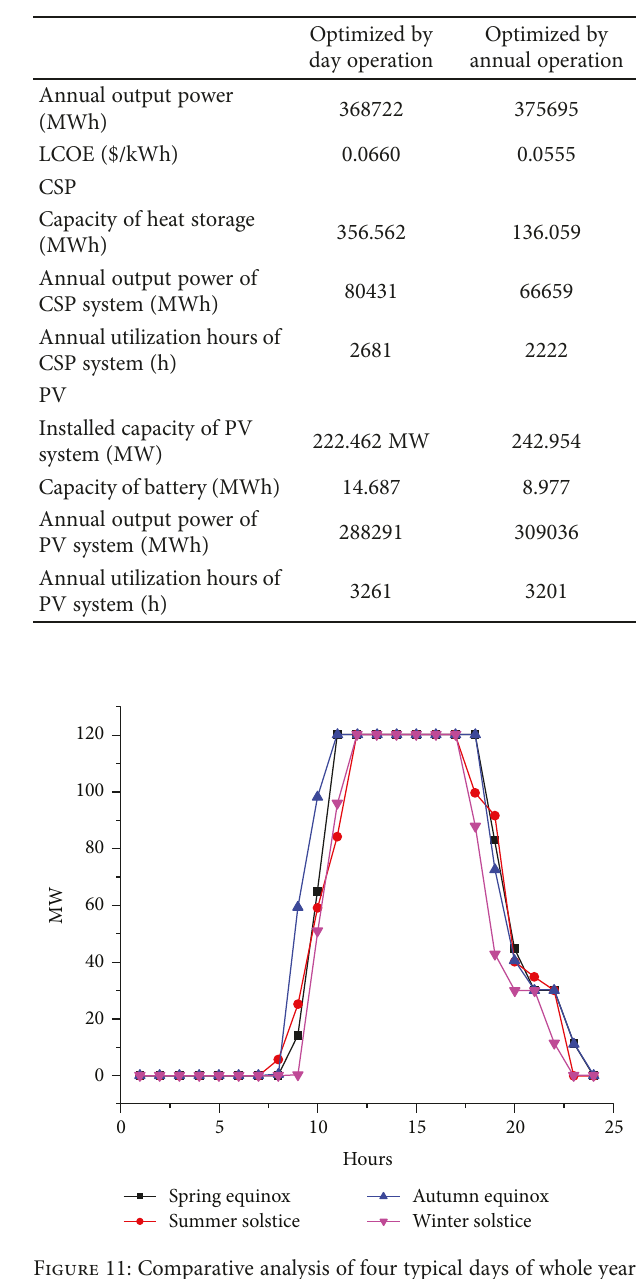
Table 7: Comparison between annual and day optimization.